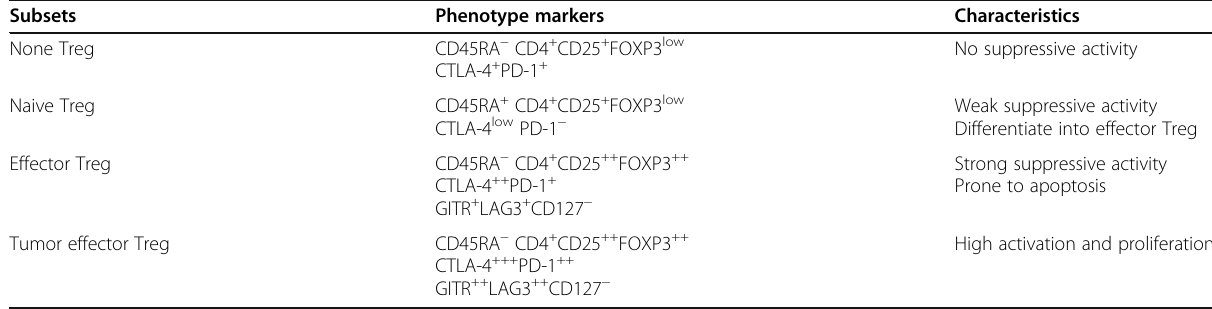
Table 1 Characteristic of human FOXP3 + CD4 + T cells in blood and tumor